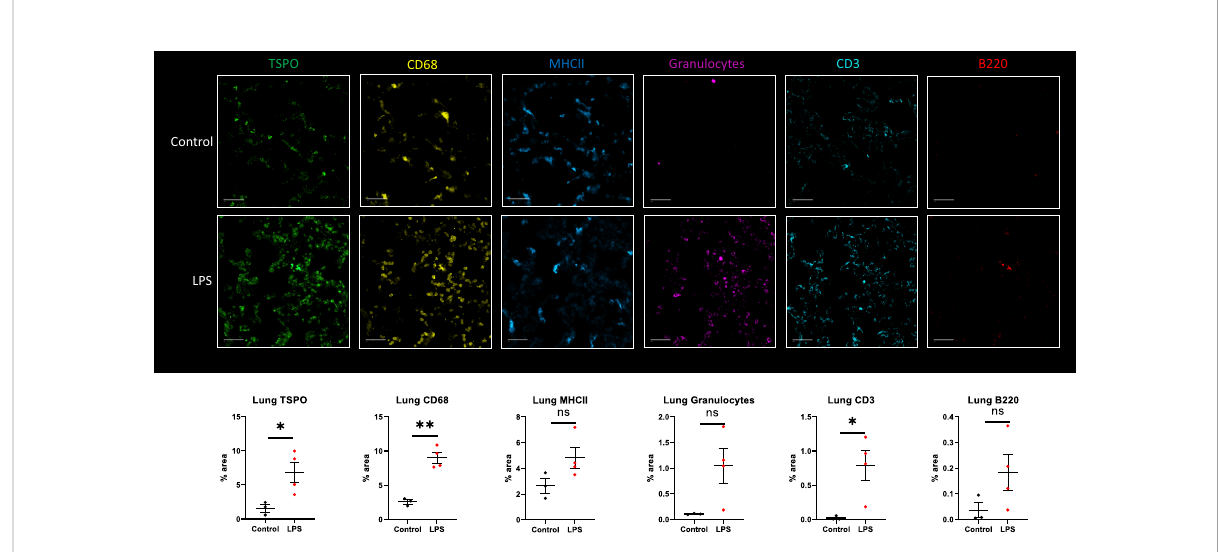
FIGURE 6 Immunohistochemistry in lung tissue sections. Representative MF-IHC images of a single lung section from control (top panels) and LPS treated rat (bottom panels). Quanti fi cation of the various stains was obtained by measuring whole lung section using Image J. Percentage area values are shown under each panel for TSPO, CD68 (macrophages), MHCII (dendritic cells), Granulocytes (neutrophils), CD3 (T cells), and B220 (B cells). There is increased TSPO (p=0.0361), CD68-monocytes/macrophages (p=0.001), and CD3-T cells (p=0.0305) staining in the lungs of LPS-treated rats (n=4) compared to controls (n=3). In this speci fi c animal, staining for TSPO, macrophages, MHCII, granulocytes and lymphocytes was increased. Statistical analysis was performed using unpaired t-test. Mean with SEM are shown. p-values <0.05 are considered statistically signi fi cant. *p<0.05, **p<0.01, not signi fi cant (ns.)